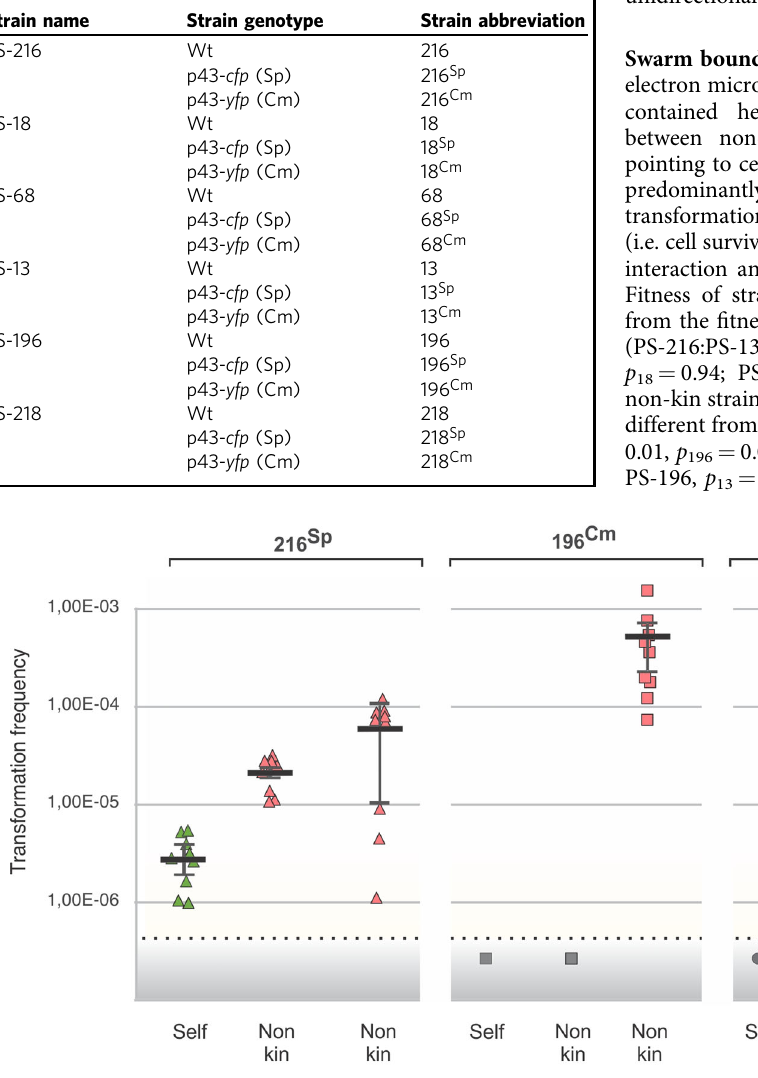
Table 2 Strain abbreviations.